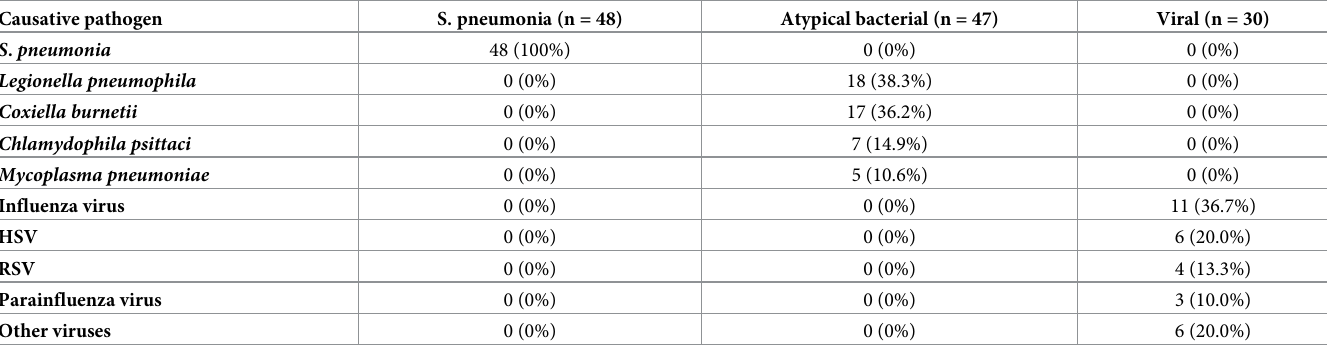
Table 2. Distribution of causative microbial agents per pathogen group for statistical data analysis. Causative